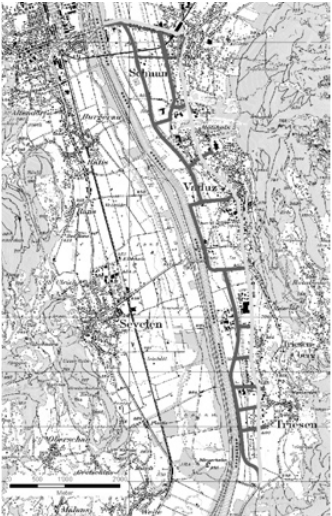
Fig. 2. Dedicated PT lane on the existing main road (right) and new bypass road